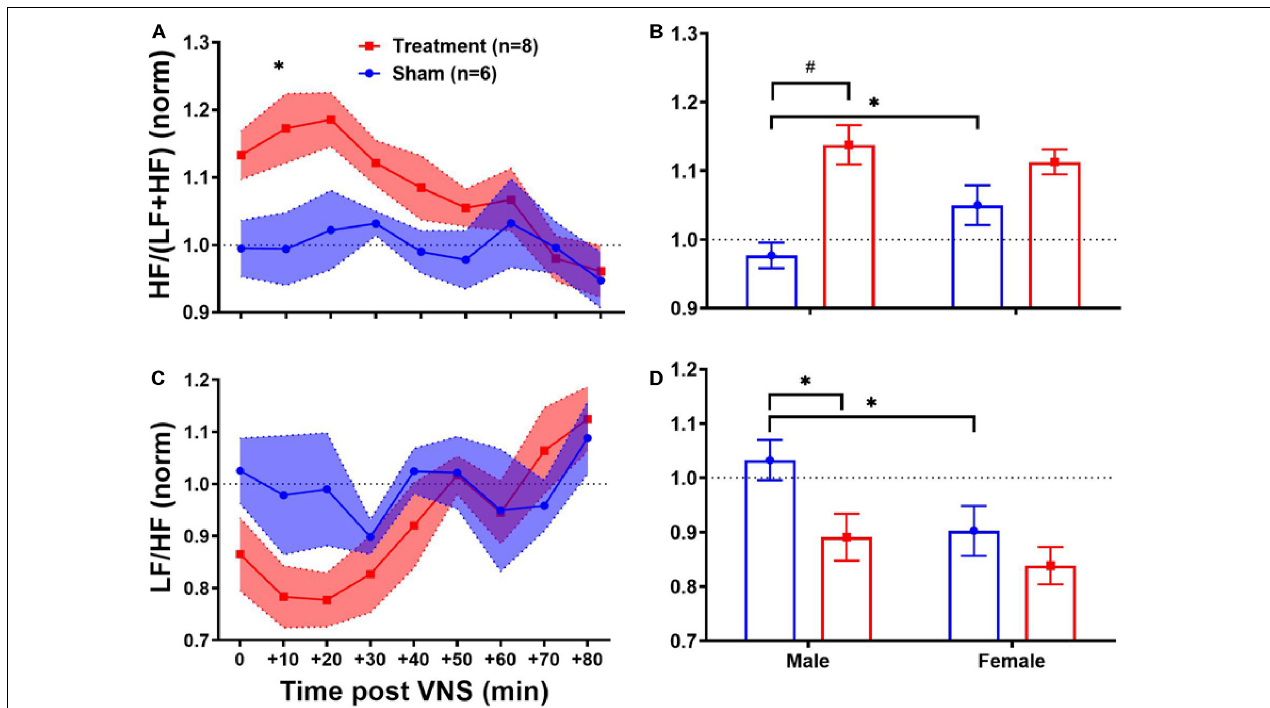
FIGURE 5 | Normalized short-term trends for HRV frequency-domain features (mean ± SEM). (A,B) HF/(LF + HF) indicating the HF proportion of total power shows significant increase in the VNS group with relatively slow transition to the baseline value. Male–female comparison shows that the effect is only significant in male rats. (C,D) LF/HF power ratio or sympathovagal balance shows reduction by VNS (not significant) and slow recovery indicating the predominance of parasympathetic modulation. Male–female comparison shows that the effect is only significant in male rats. * p < 0.05 and # p <